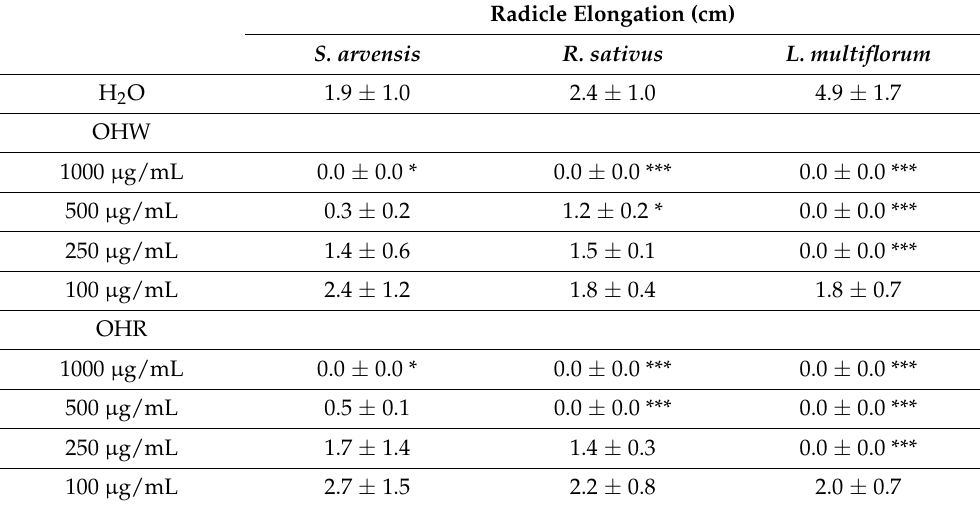
Table 3. Phytotoxic activity of the essential oils of O. heracleoticum against radicle elongation of R. sativus , S. arvensis and L. multiflorum 120 h after sowing. Results are expressed as the mean of three experiments ±